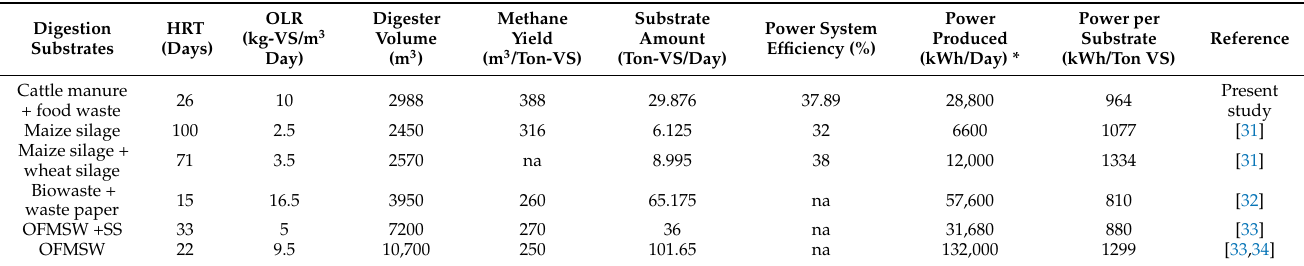
Table 7. Comparison of power production potential of